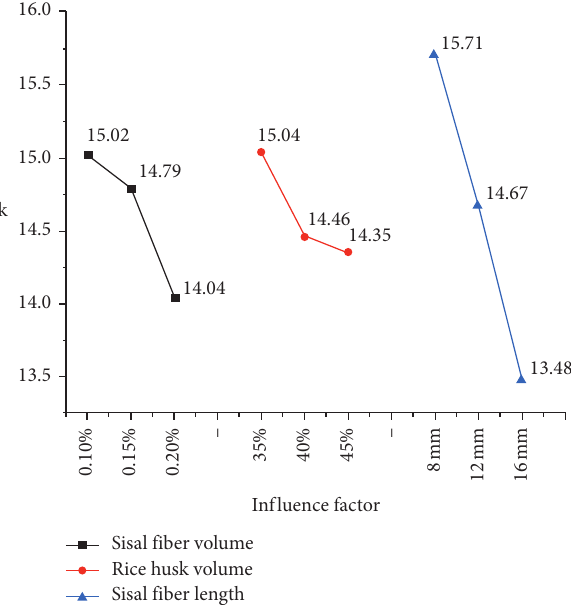
Figure 5: k value diagram of the compressive strength.